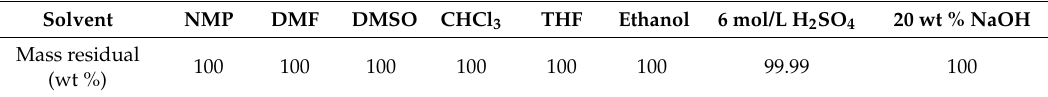
Table 5. The mass residual of CLA-PAN-230 membrane dissolved in common